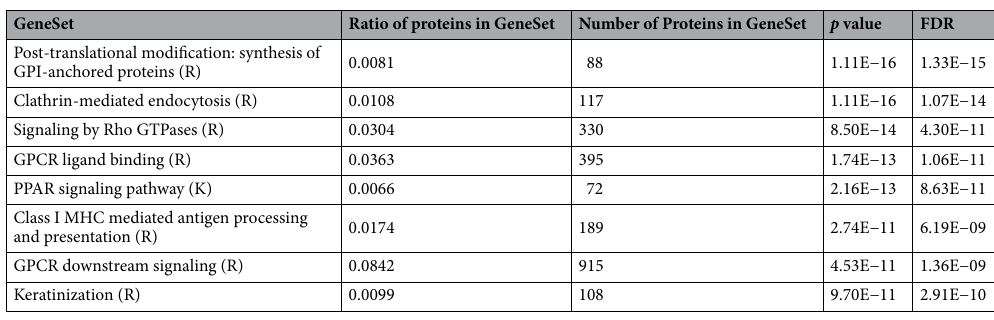
Table 1. Gene set enrichment analysis of genes showing twofold expression change following CDX2 deletion and Cdx2 binding in wild type litter